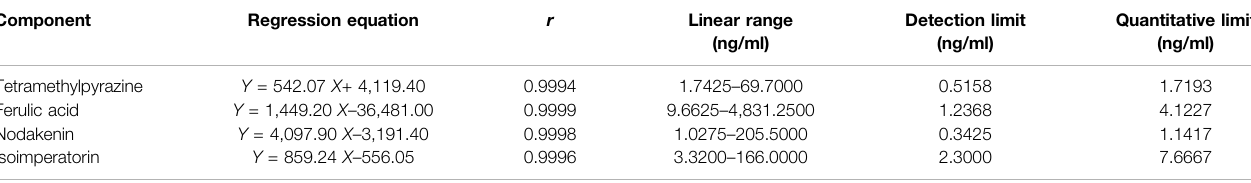
TABLE 6 | Regression equation and linear range of the standard curve of tetramethylpyrazine, ferulic acid, nodakenin, and isoimperatorin in rabbit plasma. Component Regression equation